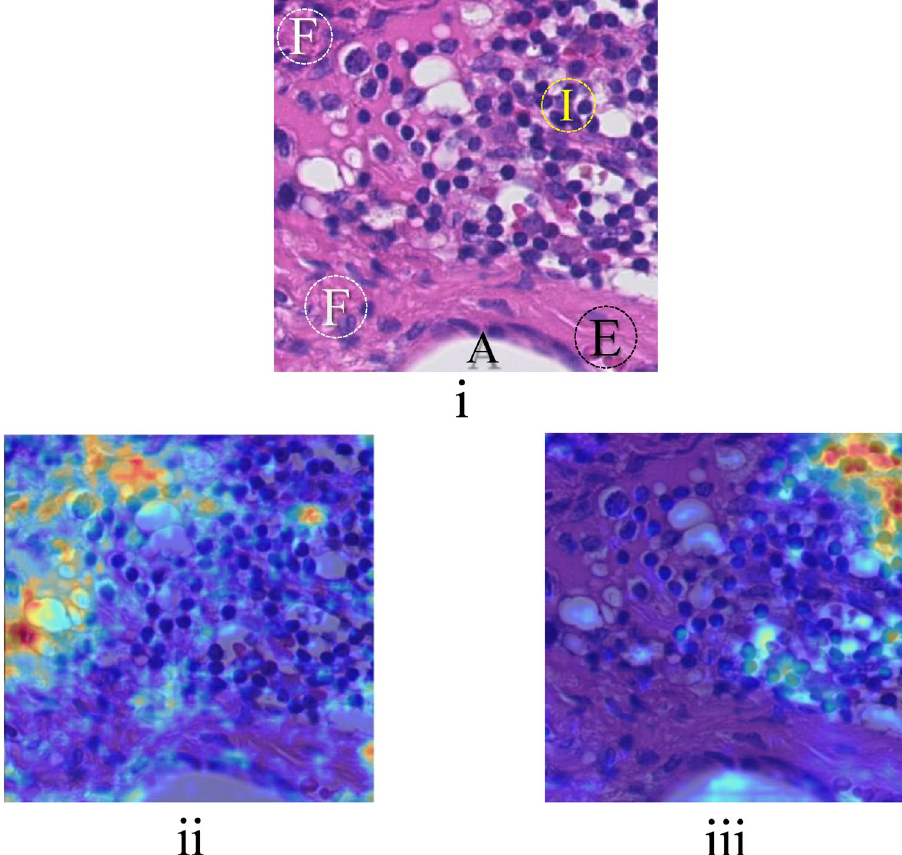
Figure 7. ( i ) an OOD healthy patch with different anatomical structures, Ⓘ : Immune cells, Ⓐ : Adipocyte, Ⓕ : Fibrous tissue, Ⓔ : Erythrocyte. ( ii ) GradCAM heatmap for the model trained using scenario 1 which misclassified the patch as a healthy patch. ( iii ) GradCAM heatmap for the model trained using scenario 2 which correctly classified the